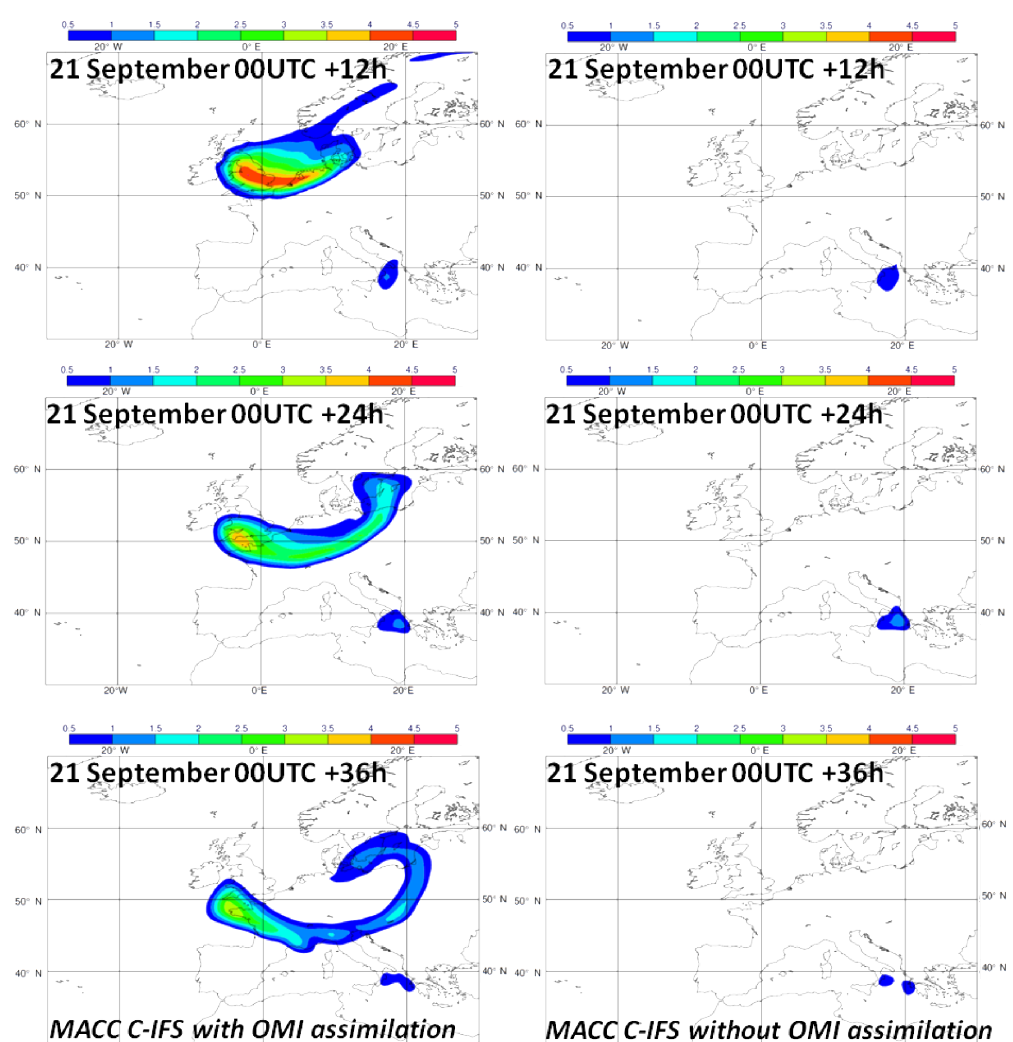
Figure 6. Charts of forecasted total column SO 2 produced within the MACC system for 21 September 2014 with OMI data assimilation (left) and without OMI data assimilation